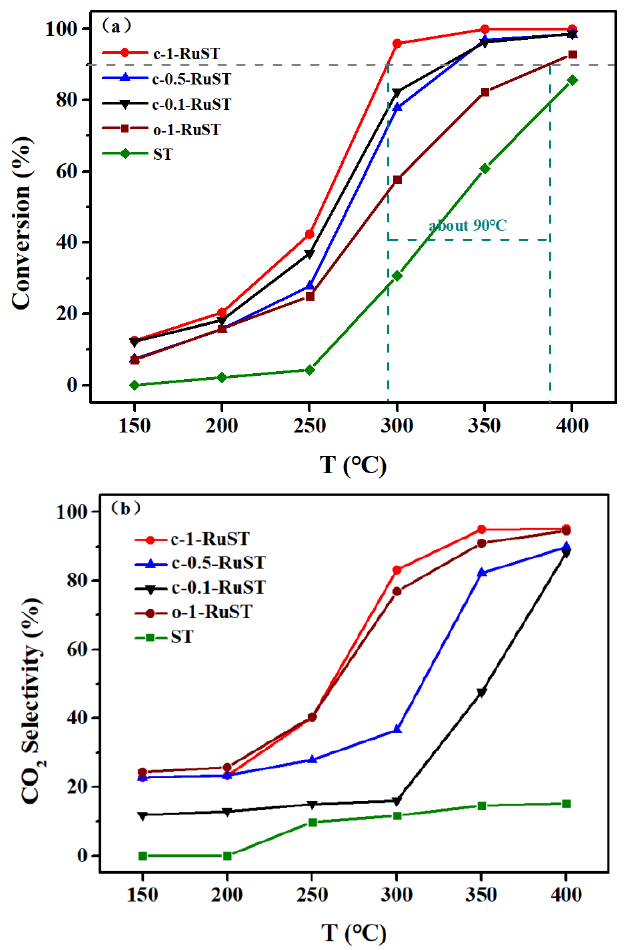
Figure 1. DCM catalytic oxidation performance test results for each sample: ( a ) DCM conversion and ( b ) CO 2 selectivity. Test conditions: (DCM) = 1000 ppm, GHSV = 45,000 mL · g − 1 · h − 1 .